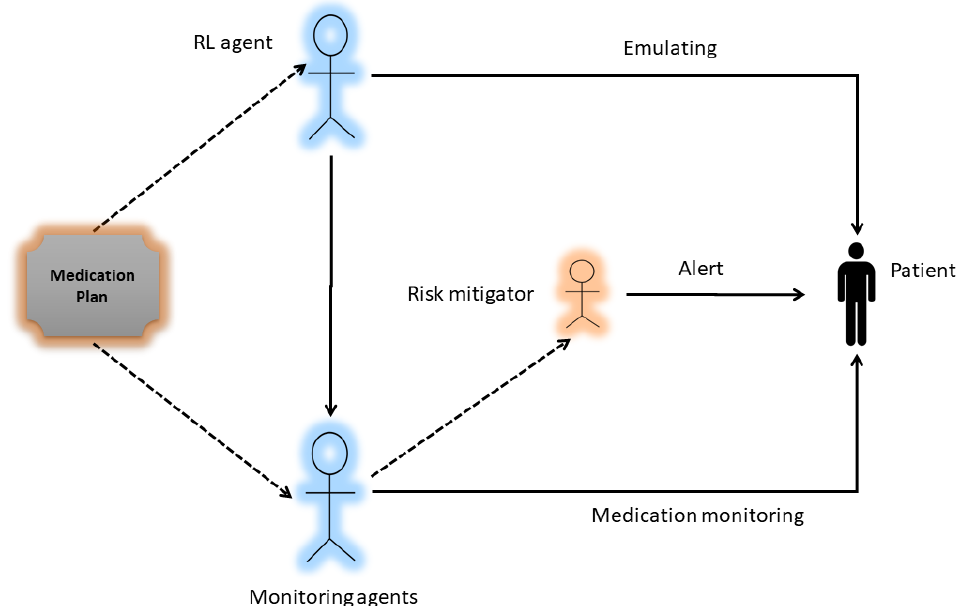
Figure 3. Block diagram of the